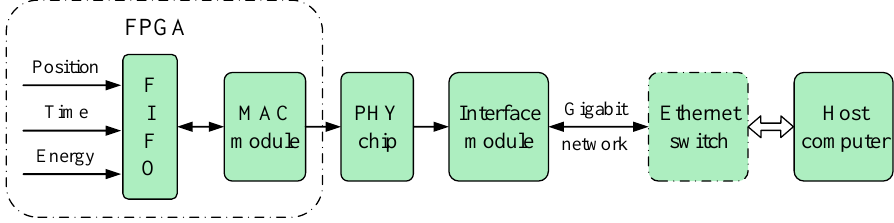
Figure 9. Illustration of the data transmission